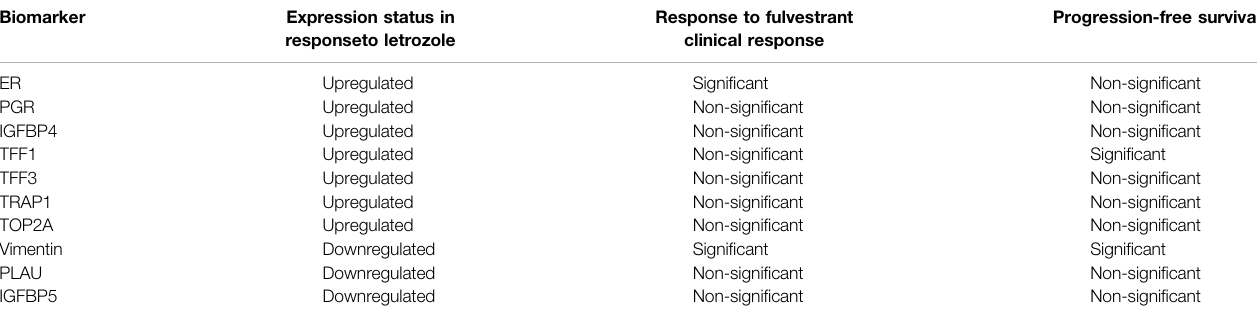
TABLE 2 | Biomarkers associated with estrogen/antiestrogen